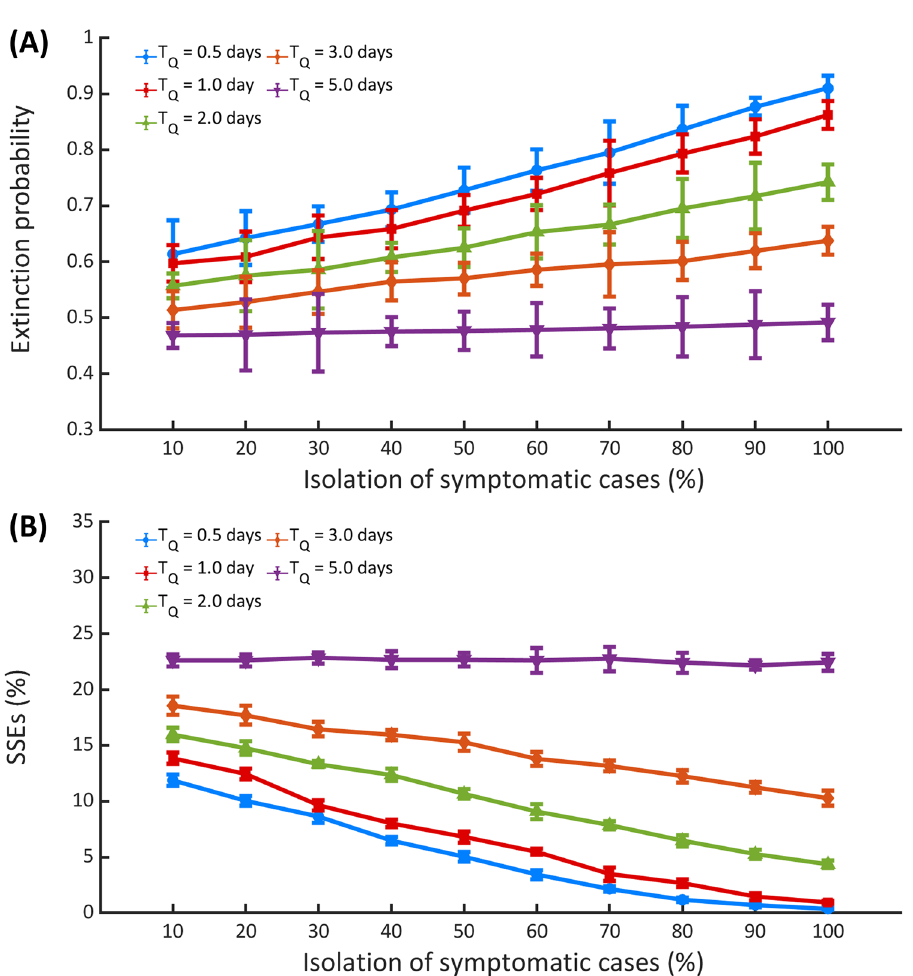
Figure 5. Impact of interventions. ( A ) The impact of symptomatic case isolation on the outbreak extinction ( A ) and the likelihood of SSEs ( B ). Error bars show the 95%